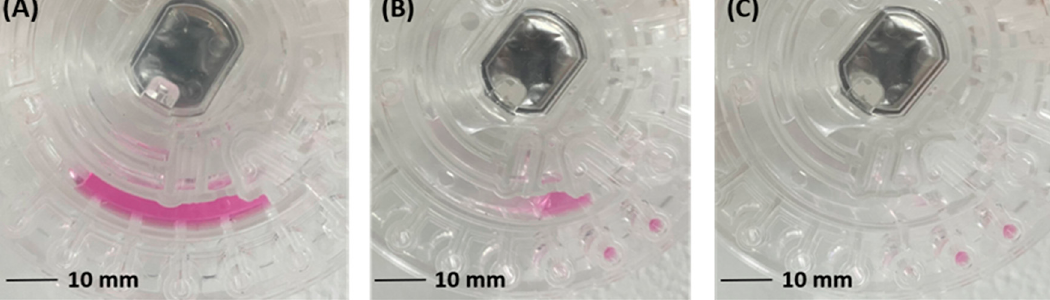
Figure 7. Liquid transfer on chip: ( A ) liquid loading; ( B ) liquid transfer; ( C ) residual liquid extraction.